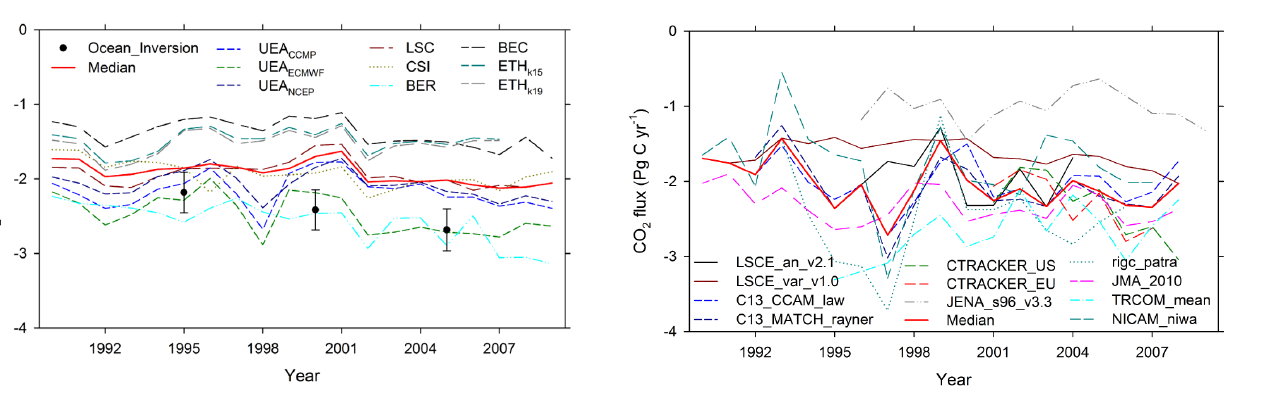
Fig. 7. The 20yr record of annual globally integrated sea–air CO 2 fluxes from atmospheric inverse models. The red line is the median of all the inverse models